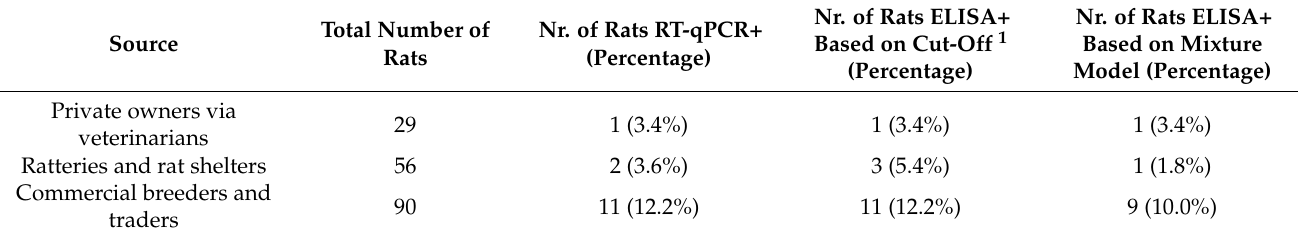
Table 2. Results of Seoul virus (SEOV)